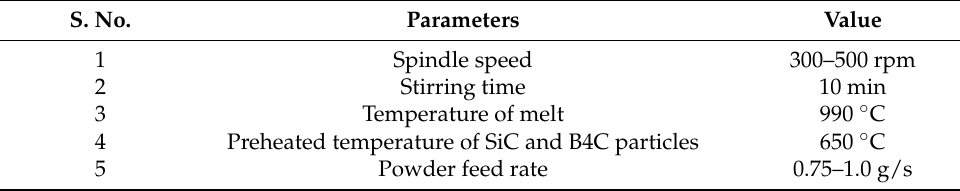
Figure 1. Schematic of stir casting setup. Table 1. Process parameters for stir